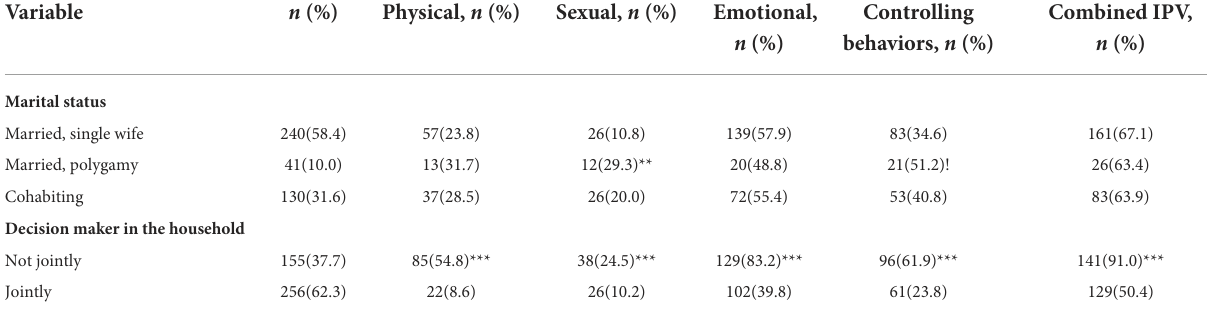
TABLE 5 Bivariate analysis showing family demographic factors associated with intimate partner